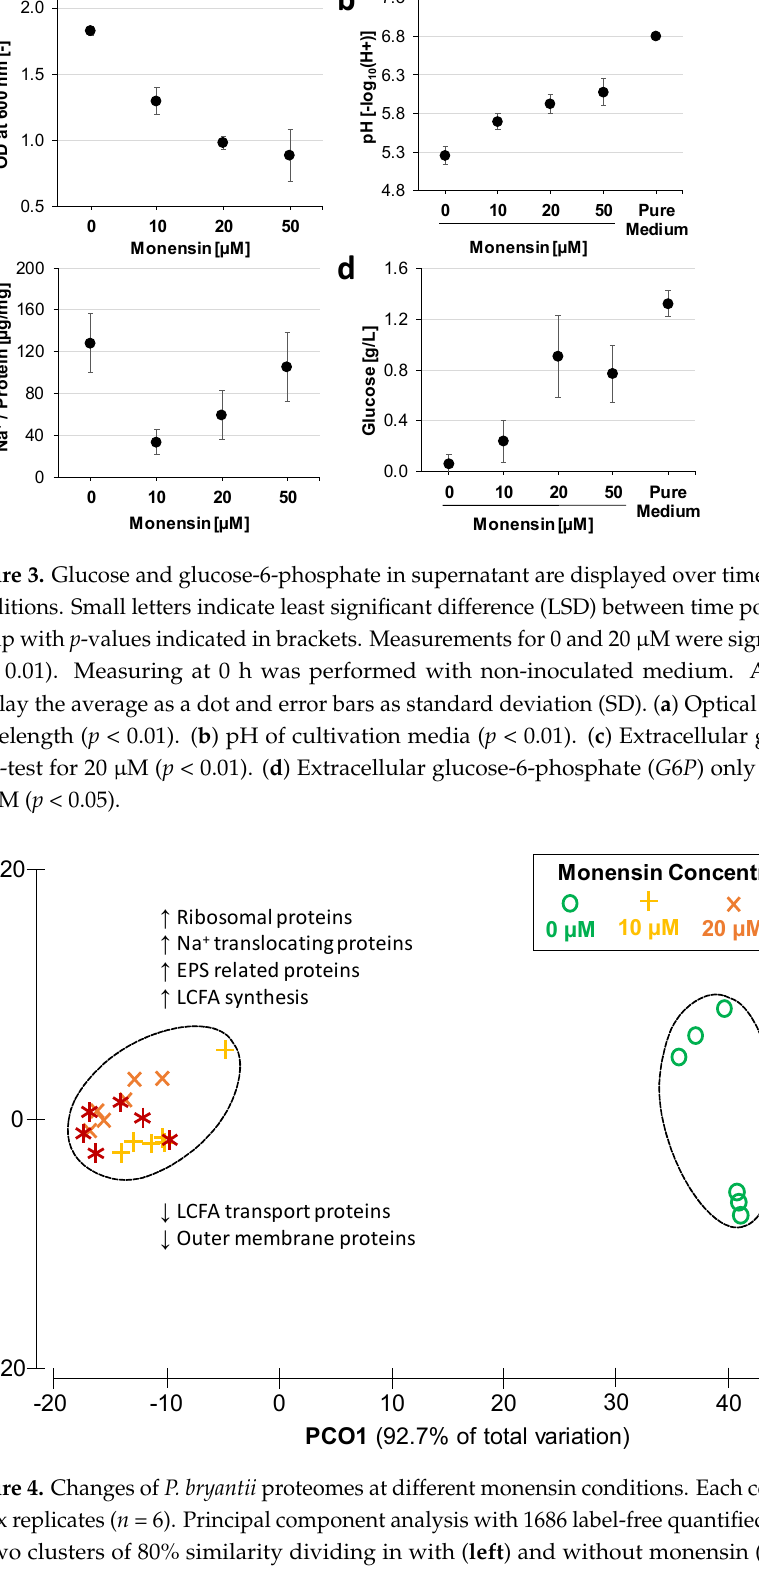
4 of 17 Figure 2. Growth and fermentation in the presence of monensin triggers intracellular sodium efflux in P. bryantii B 1 4. ( ⚪ 0 µM and ⚫ 20 µM). Parameters were obtained from 100 mL cultivations after 9 h growth under monensin concentrations (0, 10, 20 and 50 µM). The average of six biological rep- licates was displayed for every measurement and condition. Error bars indicate standard deviation